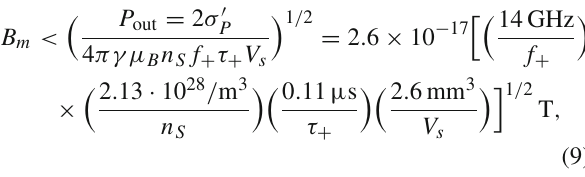
is fitted to the averaged spectrum and the residuals